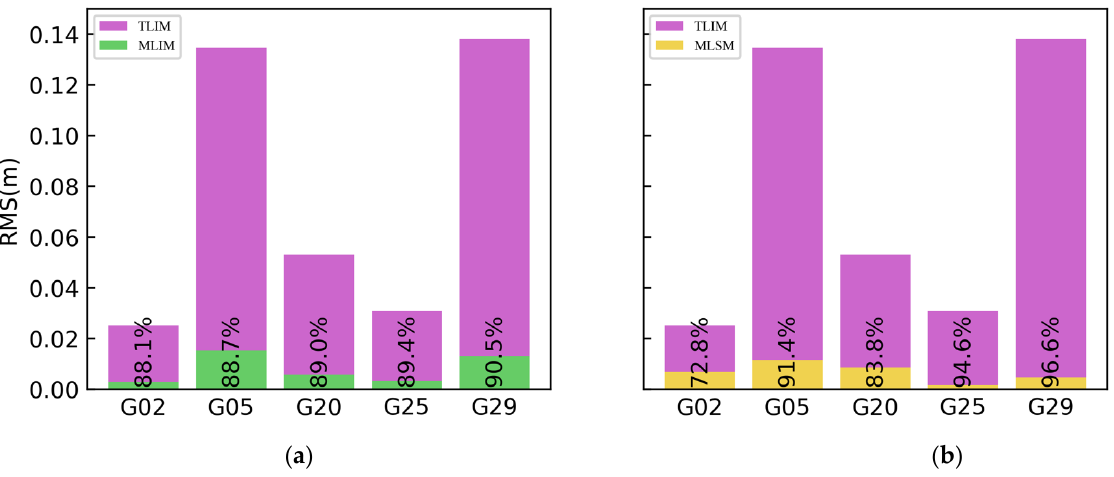
Figure 5. The DD tropospheric delay RMS and improvement ratio obtained by MLIM compared to TLIM ( a ); the DD tropospheric delay RMS and improvement ratio obtained by MLSM compared to TLIM ( b ).